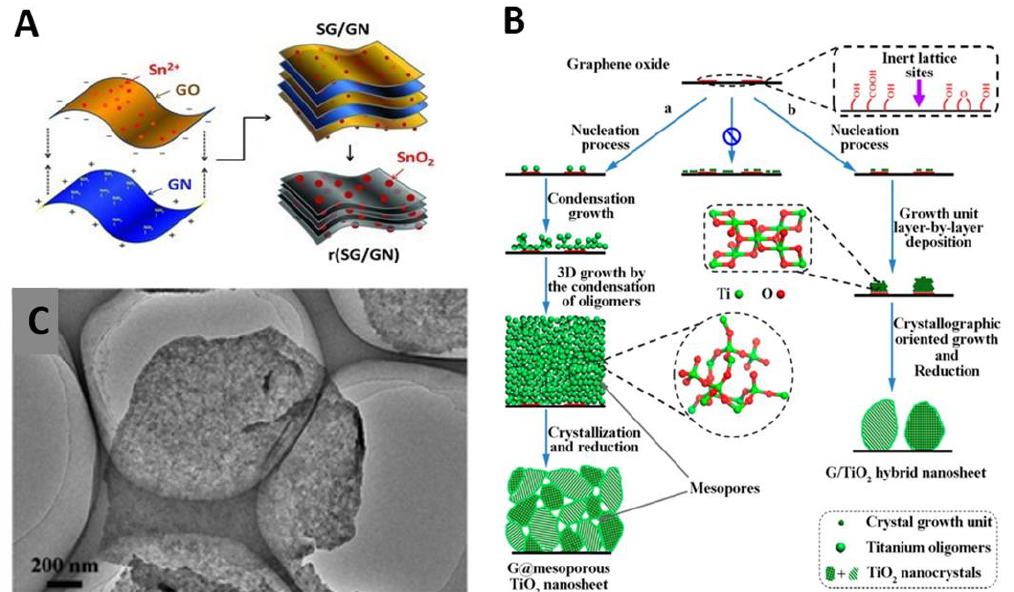
Figure 5. ( A ) Scheme of the fabrication of SnO 2 /G composites with alternating stacks of SnO 2 /GO and GN. Reprinted with permission from Ref. [90], Copyright (2013) John Wiley and Sons. ( B ) Scheme of the comparison of the amorphous-to-crystalline strategy for uniform mTiO 2 deposition on G and conventional synthetic methodologies to growing TiO 2 nanocrystals on G into hybrids. ( C ) TEM image of the TiO 2 /GO nanosheets with ammonia content of 0.15 mL. ( B , C ) Reprinted with permission from Ref. [97], Copyright (2015) American Chemical Society.